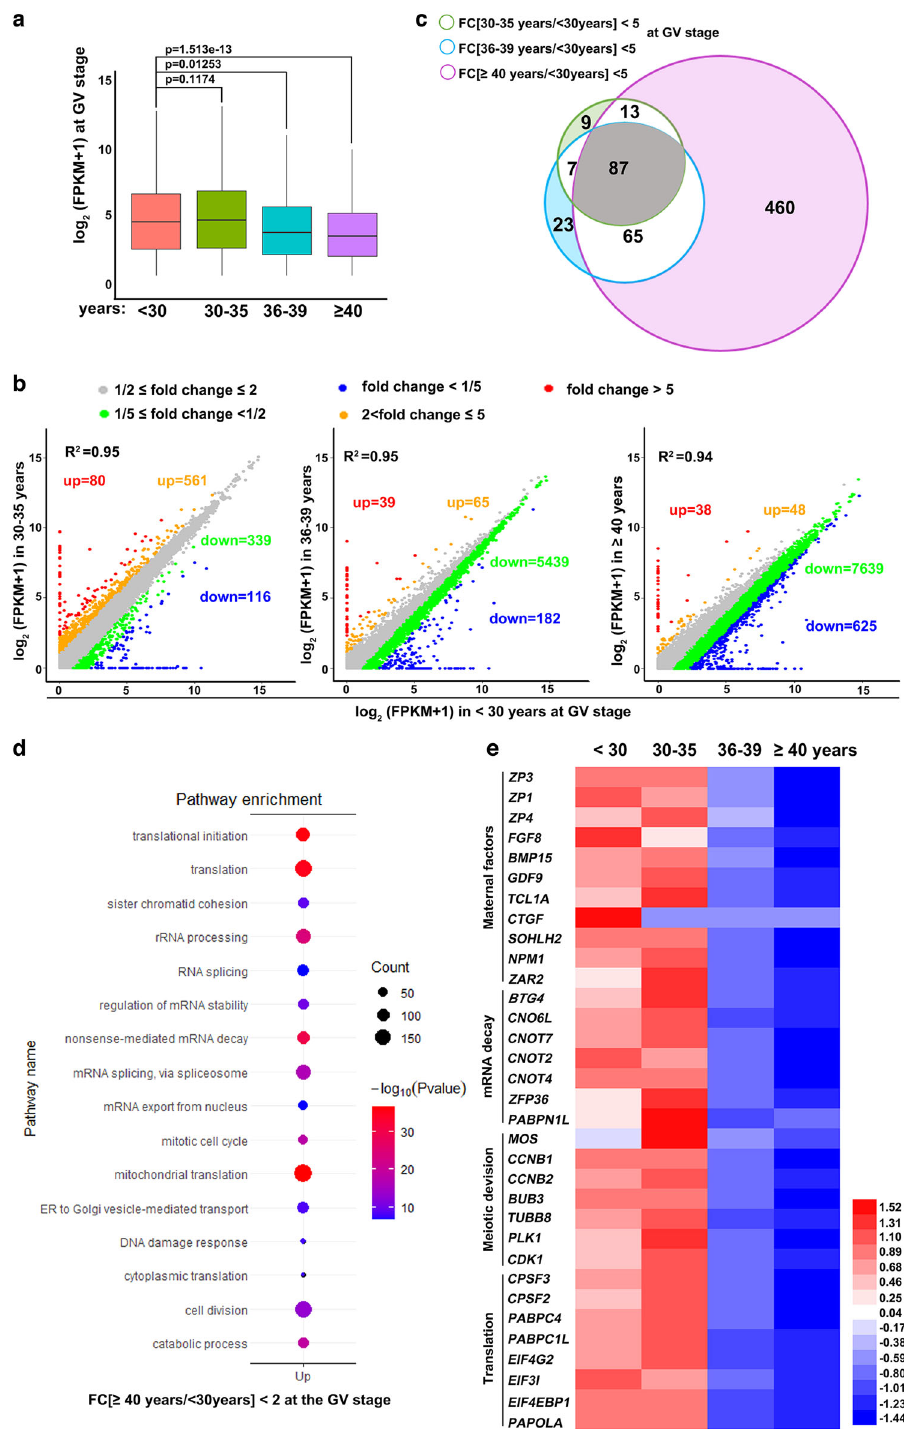
Fig. 1 Age-associated transcriptome changes in human oocytes at the GV stage. a Box plot showing the gene expression levels in human GV oocytes of different ages. n = 3 biologically independent samples were included in each group. The box indicates the upper and lower quantiles, the thick line in the box indicates the median and whiskers indicates 2.5th and 97.5th percentiles.. P-values by a two-tailed Student ’ s t -test are indicated. b Scatter plots of RNA-seq data illustrating transcriptional changes in human GV oocytes of different ages. Transcripts decreased or increased by more than 2-fold or 5-fold compared with oocytes of women younger than 30 years old were highlighted with different colors. c Venn diagram showing the overlap of transcripts that decreased more than 5 fold in GV oocytes from women of different ages, compared with oocytes of women younger than 30 years old. d Gene ontology analysis of transcripts signi fi cantly downregulated in aged GV oocytes. P-values by a two-tailed Student ’ s t -test are indicated. e Heat maps showing the level changes in representative transcripts in the indicated functional